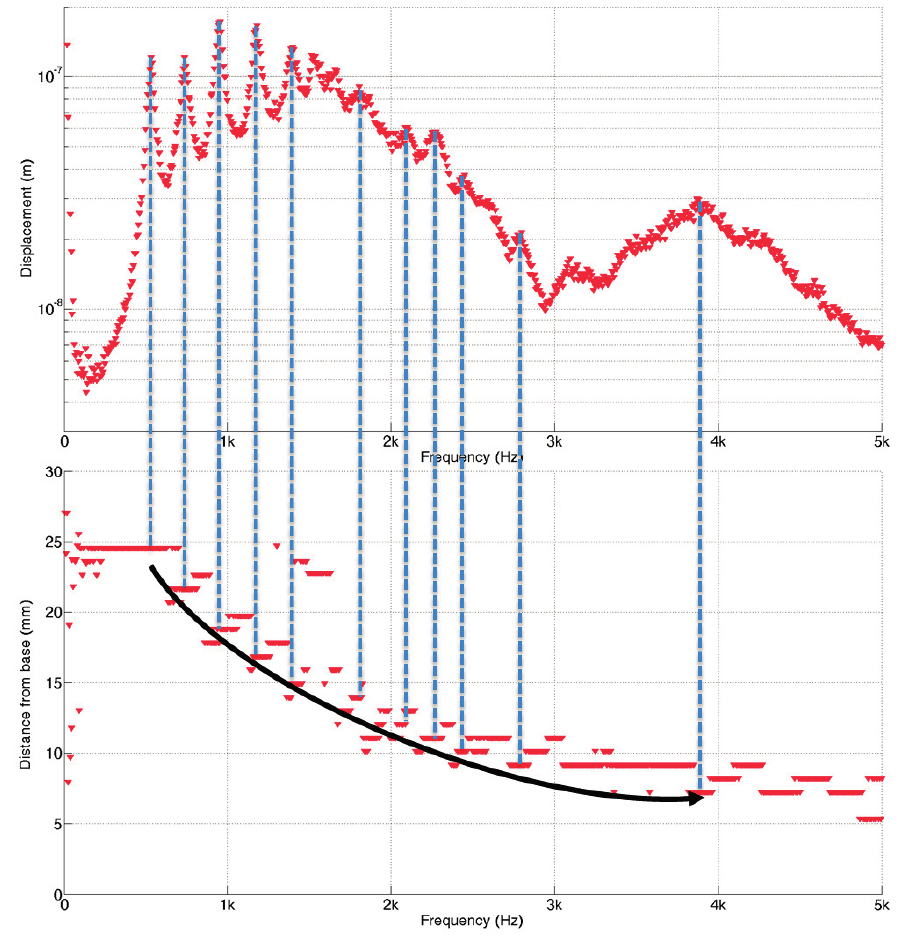
Figure 13. Frequency separation properties of the packaged PAC: top graph represents the maximum displacement on the membrane and bottom graph represents the position having maximum displacement at each frequency expressed by the distance from the